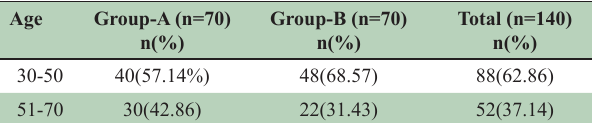
Table-I: Distribution of age.